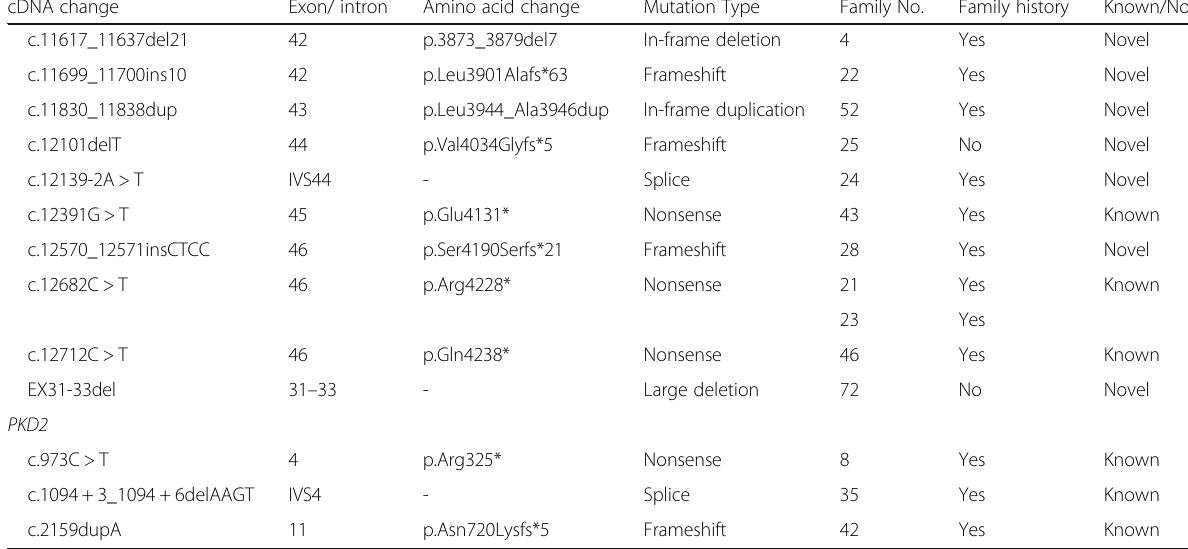
Table 1 Defnitely pathogenic mutations in PKD1 and PKD2 identified in this study (Continued) cDNA change Exon/ intron Amino acid change Mutation Type Family